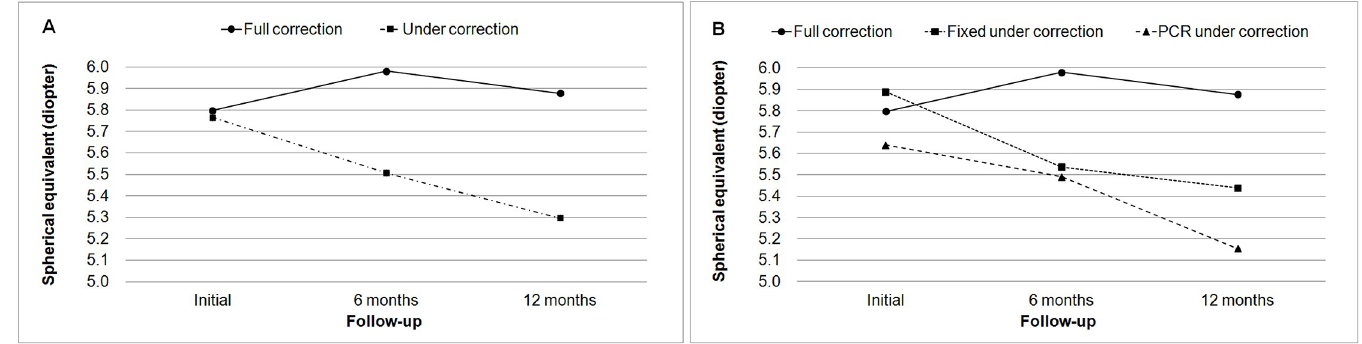
Fig 1. Changes in hyperopia and the progression of emmetropization in the full correction and under-correction groups. (A) Initial hyperopiawas significantlyreducedin the under-correction group duringfollow-up(P < 0.001). (B) The amount of hyperopia under-correction was correlatedwith the amount of hyperopia reduction(P =